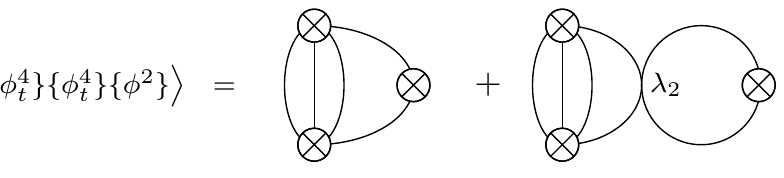
Figure 15 . Leading order diagrams